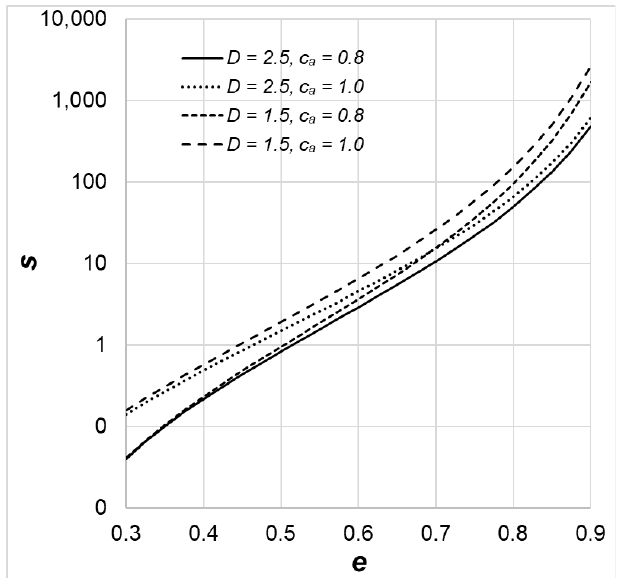
Figure 4. The standard deviation of dimensionless permeability s as a function of the porosity e for a few selected values of the power-law distribution parameters.